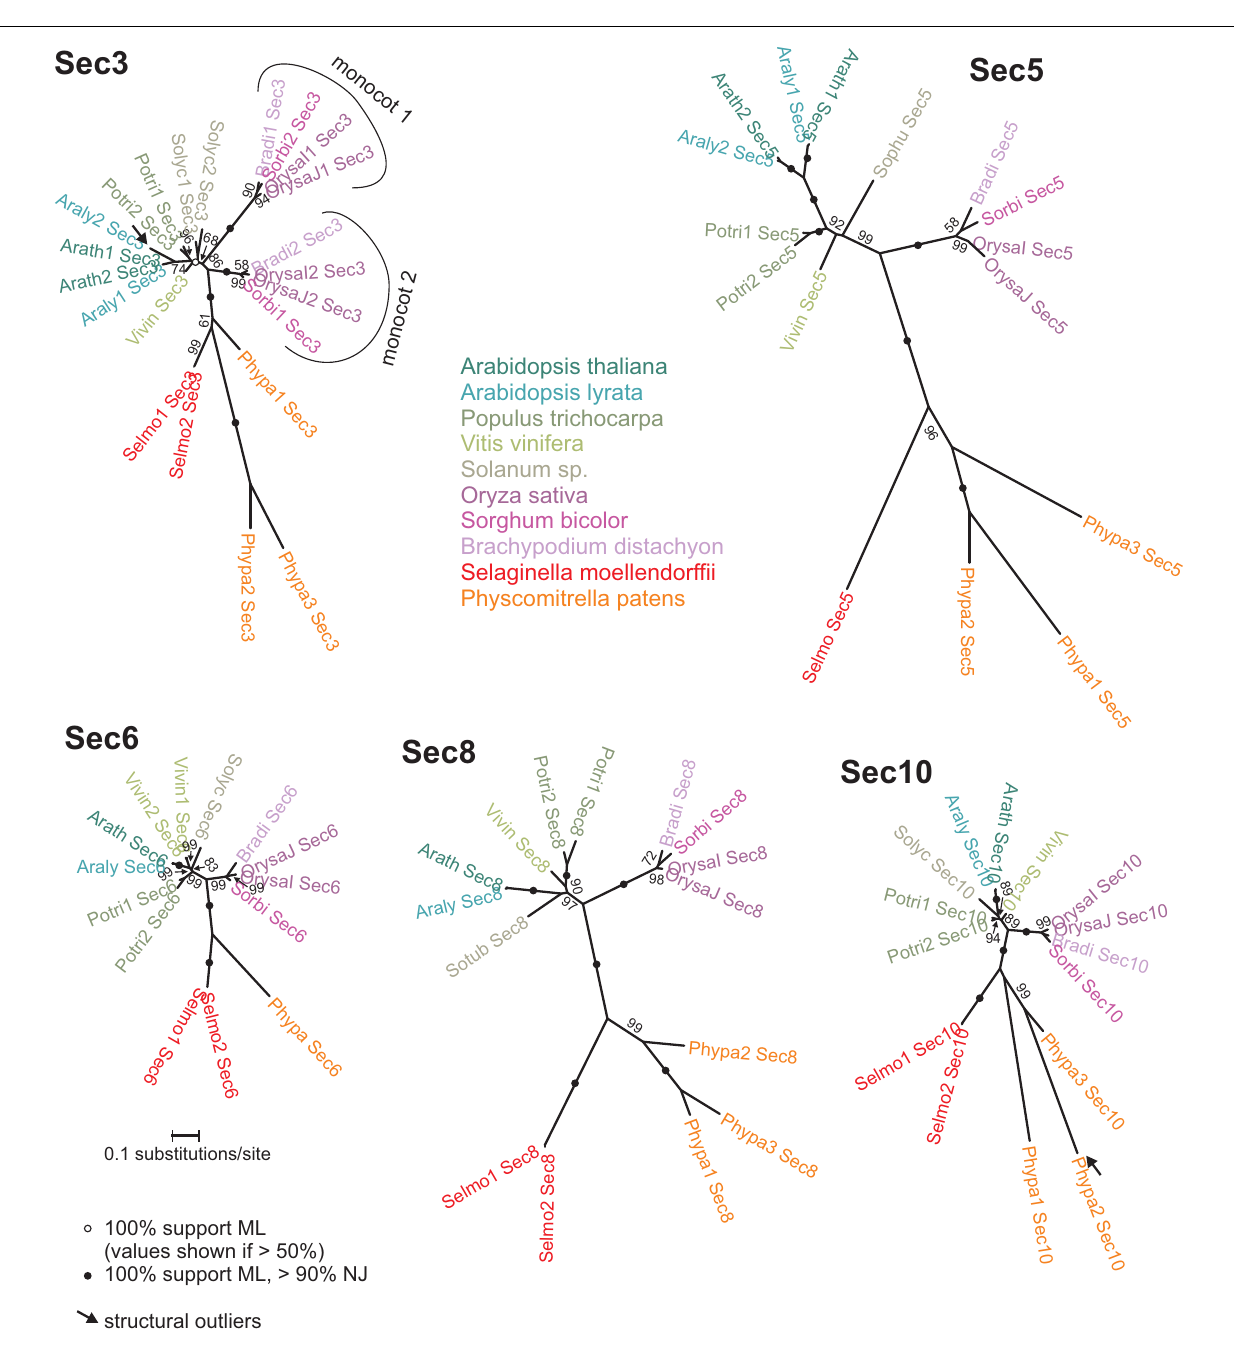
FIGURE 1 | Unrooted maximum likelihood (ML) phylograms of the low copy Exocyst subunits. All SH-like support values above 50% from the aLRT test are shown. Consistent trees were obtained also using the neighbor-joining (NJ) method with 1000 bootstrap samples; nodes with high